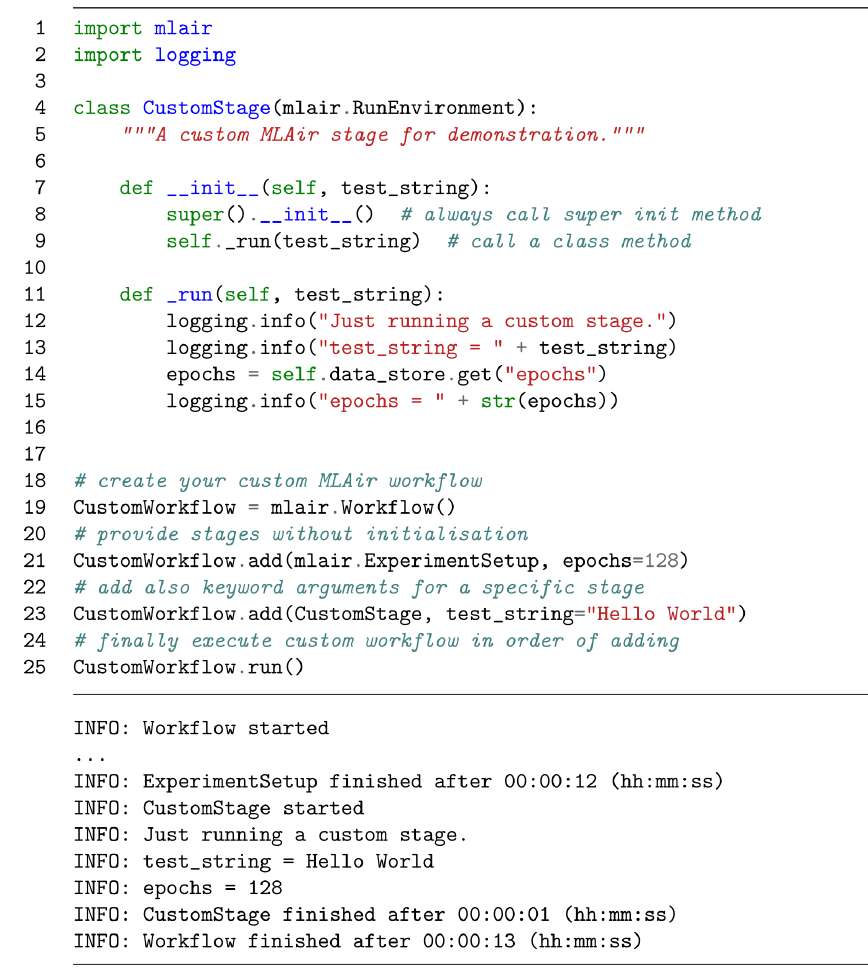
Figure 15. Embedding of a custom run module in a modified MLAir workflow. In comparison to Figs. 2, 3, and 4, this code example works on a single step deeper regarding the level of abstraction. Instead of calling the run method of MLAir , the user needs to add all stages individually and is responsible for all dependencies between the stages. By using the Workflow class as context manager, all stages are automatically connected with the result that all stages can easily be plugged